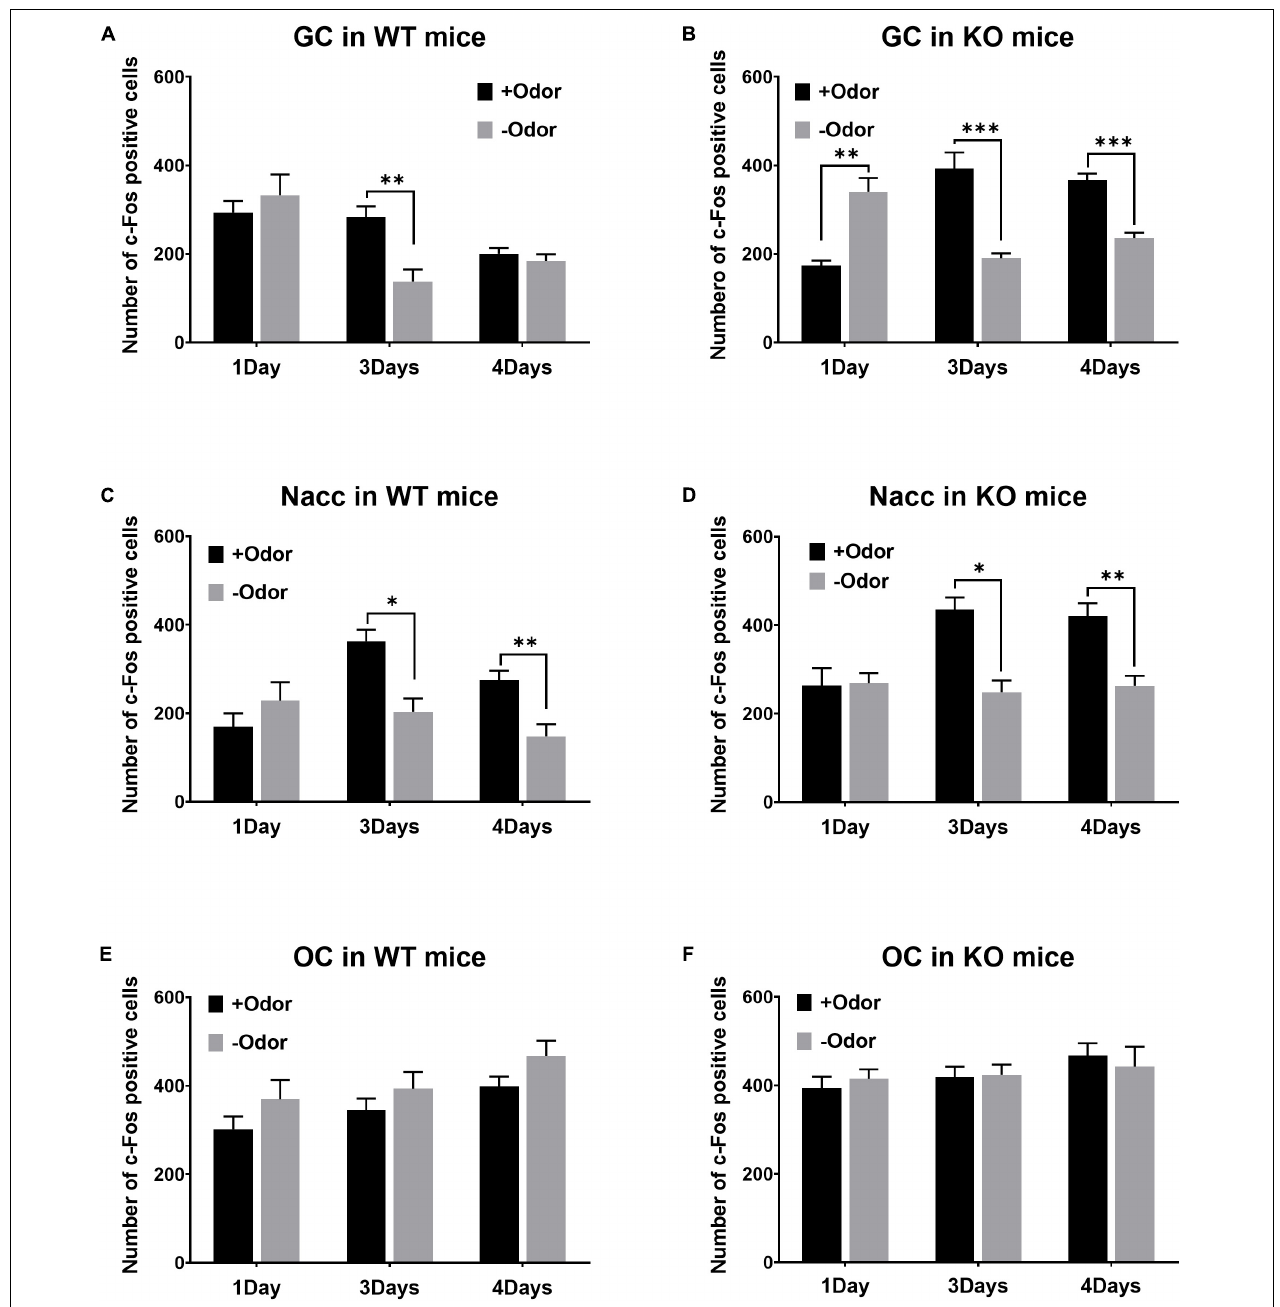
FIGURE 2 | Patterns of CS-evoked neural activation over the 4-day course of odor-sugar conditioning in wild-type (WT) and phospholipase C β 1-knockout (PLC β 1-KO) mice. (A,C,E) Number of c-Fos-positive cells (per section) after the exposure to +Odor (black) or –Odor (gray), with 1Day, 3Days, or 4Days training condition, in the GC (A,B) , the Nacc (C,D) , and the OC (E,F) of WT and PLC β 1-KO mice. Numbers of mice ( N ) and sections ( n ): (A) (WT GC: 1Day +Odor, N = 4, n = 12; 1Day –Odor, N = 3, n = 9; 3Days +Odor, N = 5, n = 15; 3Days –Odor, N = 3, n = 9; 4Days +Odor, N = 10, n = 30; 4Days –Odor, N = 9, n = 27), (B) (KO GC: 1Day +Odor, N = 3, n = 9; 1Day –Odor, N = 3, n = 9; 3Days +Odor, N = 3, n = 9; 3Days –Odor, N = 3, n = 9; 4Days +Odor, N = 6, n = 18; 4Days –Odor, N = 6, n = 18), (C) (WT Nacc: 1Day +Odor, N = 4, n = 11; 1Day –Odor, N = 3, n = 6; 3Days +Odor, N = 5, n = 15; 3Days –Odor, N = 3, n = 9; 4Days +Odor, N = 10, n = 30; 4Days –Odor, N = 9, n = 18), (D) (KO Nacc: 1Day +Odor, N = 3, n = 9; 1Day –Odor, N = 3, n = 9; 3Days +Odor, N = 3, n = 9; 3Days –Odor, N = 3, n = 9; 4Days +Odor, N = 6, n = 18; 4Days –Odor, N = 6, n = 17), (E) (WT OC: 1Day +Odor, N = 4, n = 12; 1Day –Odor, N = 3, n = 9; 3Days +Odor, N = 5, n = 15; 3Days –Odor, N = 3, n = 9; 4Days +Odor, N = 10, n = 30; 4Days –Odor, N = 9, n = 22), (F) (KO OC: 1Day +Odor, N = 3, n = 9; 1Day –Odor, N = 3, n = 9; 3Days +Odor, N = 3, n = 9; 3Days –Odor, N = 3, n = 9; 4Days +Odor, N = 6, n = 18; 4Days –Odor, N = 6, n = 18). All the values are mean ± SEM. ∗ p < 0.05; ∗∗ p < 0.01; ∗∗∗ p <